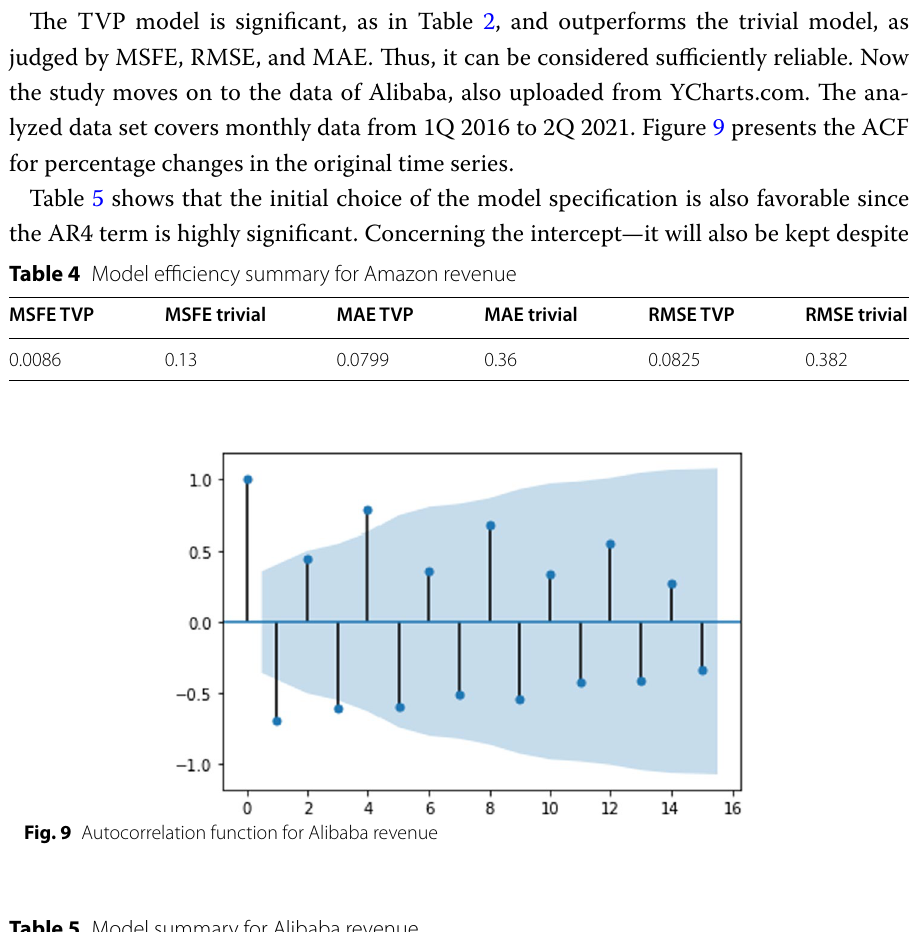
Table 5 Model summary for Alibaba revenue